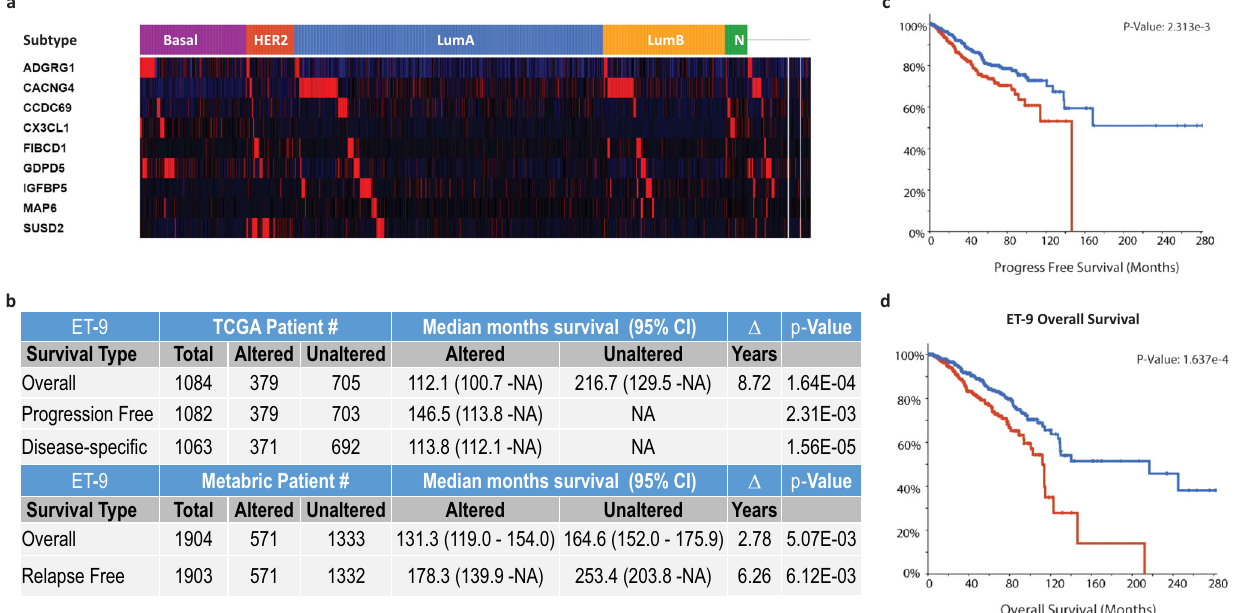
Fig. 3 ET-9 expression and breast cancer survival. a The expression heatmap of ET-9 genes in the TCGA Breast Invasive Carcinoma (BIC) RNA SeqV2 dataset, including 1084 patient samples. The subtype classi fi cation is provided above the heatmap; basal-like (purple) HER2 + (red), Luminal A (blue), Luminal B (yellow), normal-like (green). b The relative survival statistics of breast cancer patients with altered ET-9 expression in the TCGA_BIC ( n = 1084 patients) and METABRIC ( n = 1904 patients) datasets 58,59 . c Kaplan-Meier chart of ET-9 progression-free survival in the TCGA_BIC PanCancer dataset. The ET-9 altered (red line) tumors have signi fi cantly shorter progression free survival compared to ET-9 unaltered (blue line) tumors ( p = 0.00232, Log Rank test). d Kaplan-Meier chart of ET-9 overall survival in the TCGA_BIC PanCancer dataset. The ET-9 altered (red line) tumors have signi fi cantly shorter progression free survival compared to ET-9 unaltered (blue line) tumors ( p = 0.000163, Log Rank test). All the analyses ( a – c ) were carried out using cBioPortal 57